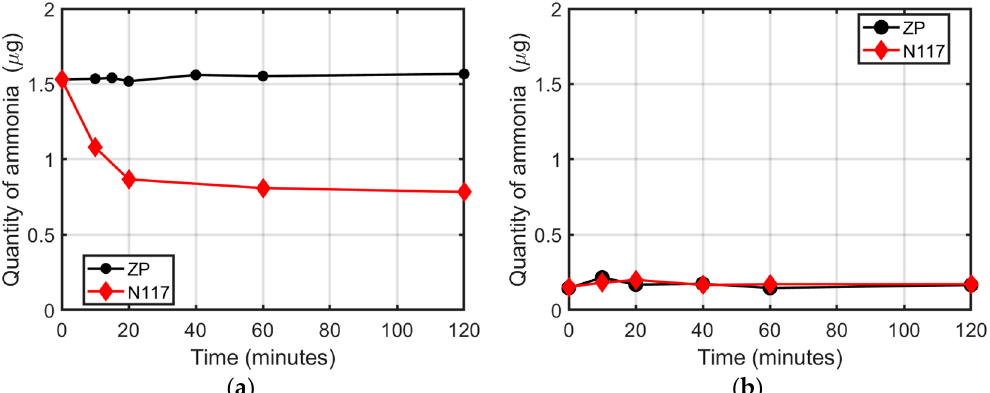
Figure 1. Ammonia quantity as a function of the immersion time: ( a ) in the water NH 4 Cl solution, with N117 or ZP (membrane absorption experiment); ( b ) in pure water after the immersion of N117 or ZP, which had previously absorbed ammonia (release experiment).